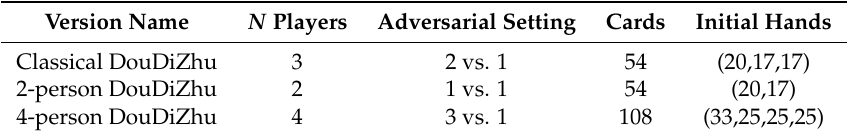
Table 7. Versions of DouDiZhu games.